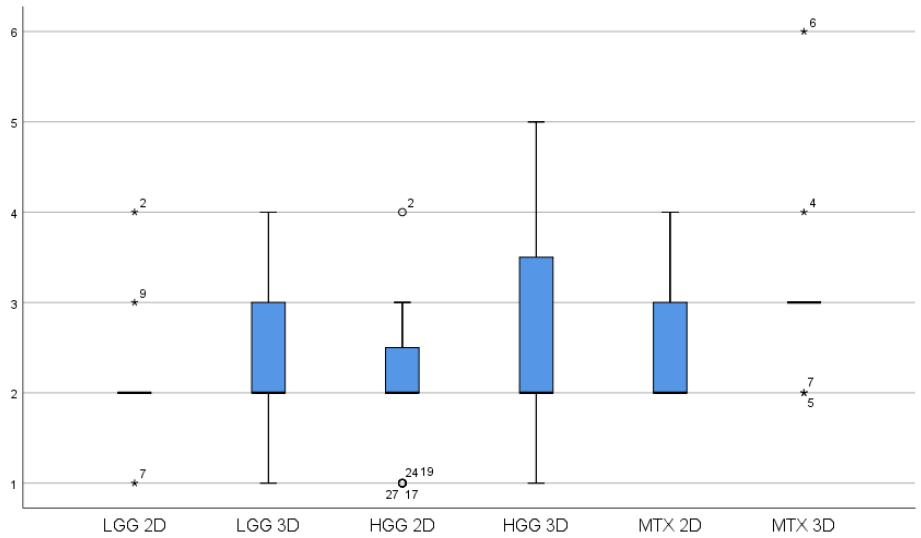
Figure 5. Box plot showing 2D and 3D benefit variations for the three main categories of tumors: HGG = high-grade gliomas, LGG = low-grade gliomas, MTX = metastases. White circles = White circles = low potential outlier (more than 1.5 inter-quartile range at most 3 inter-quartile range. * = high potential outliers of more than 3 inter-quartile ranges).